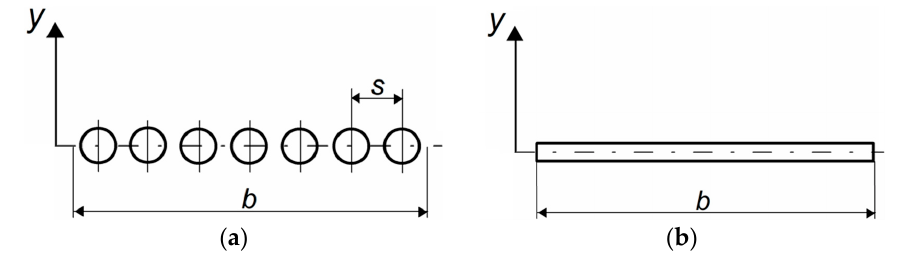
Figure 3. ( a ) Parallel pipes configuration; ( b ) Flat plate.